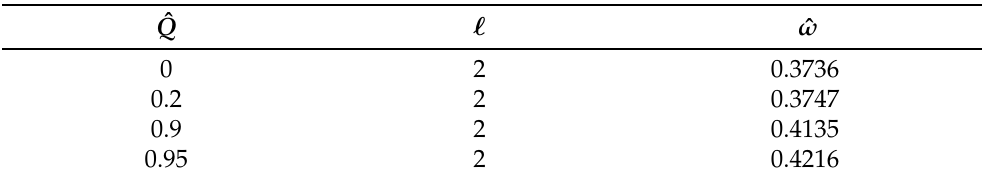
Figure 2. The gravitational ˆ R 4 and electromagnetic/gravitational ˆ R 3 signals in logarithmic scale for different values of charge ˆ Q = 0.0,0.5,0.9,0.95, and 0.97. The signals show the characteristic phases: the initial burst, the quasinormal ringing, the power-law decay, and the tail. Table 1. Frequency of the quasinormal modes of the black hole produced by the perturbation of the accreting matter. The frequencies are consistent with the values given in